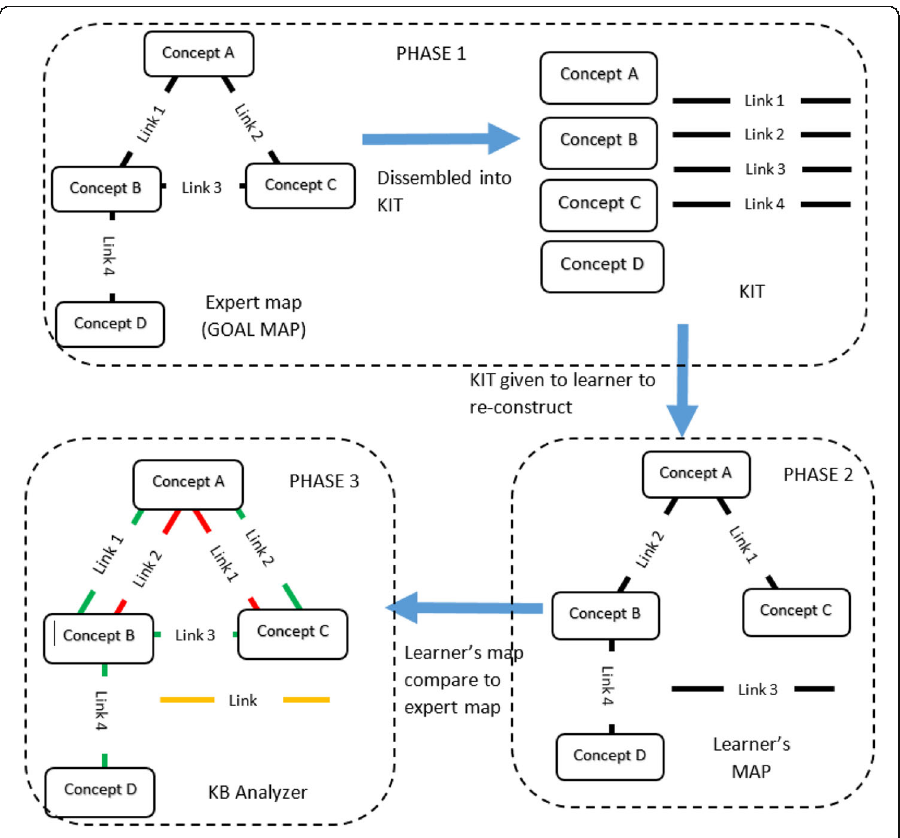
Fig. 1 KB-map system lifecycle